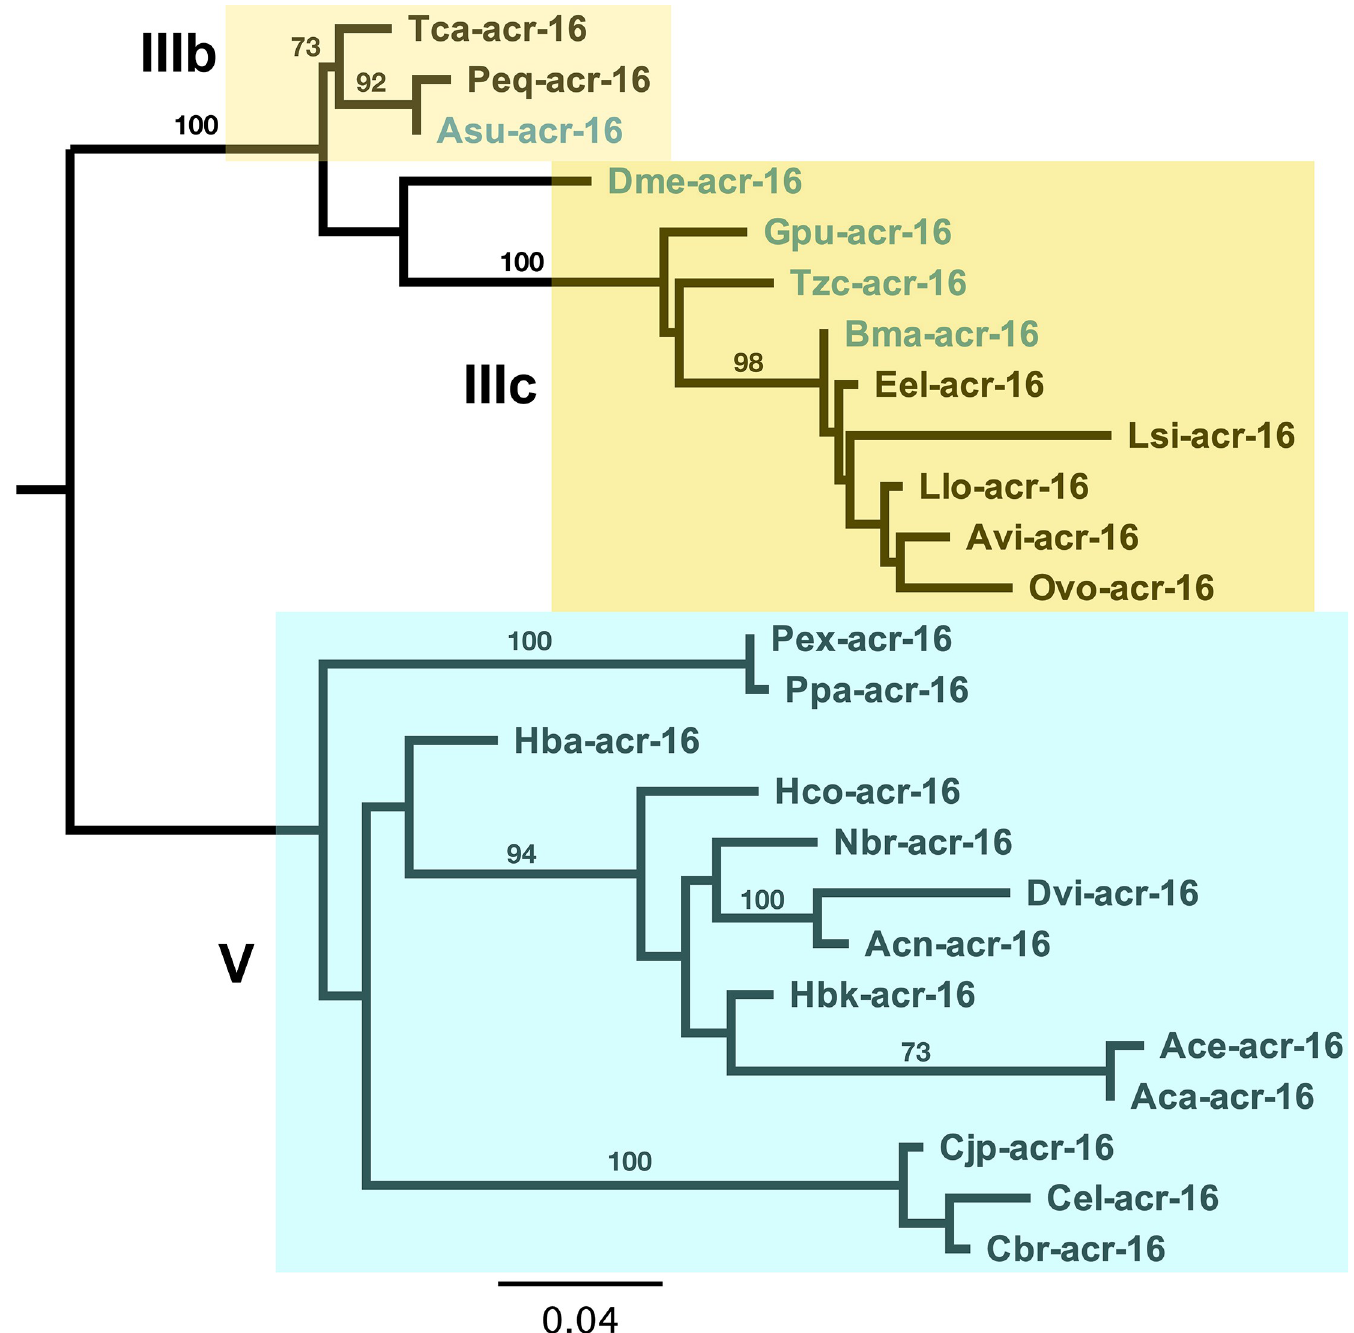
Fig 1. ACR-16 phylogeny in the nematodes. ACR-16 is conserved across worms with short branches observed within the clade III worms. Clade III and clade V ACR- 16 sequence group as expected following the worm phylogeny [37]. B . malayi ACR-16 groups within the later clade III nematodes, showing no unexpected branch topology that would explain the inability to measure a B . malayi N-AChR receptor ex vivo . Clade V sequences shaded in blue, clade IIIa in light yellow, and clade IIIb in dark yellow. Clade III ACR-16 sequences used in this study indicated in blue. Bootstrap resampling branch support values are shown. Scale bar represents substitution